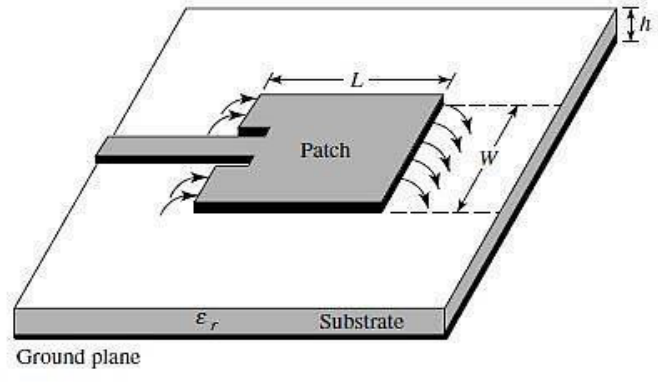
Fig. 1. Microstrip patch antenna